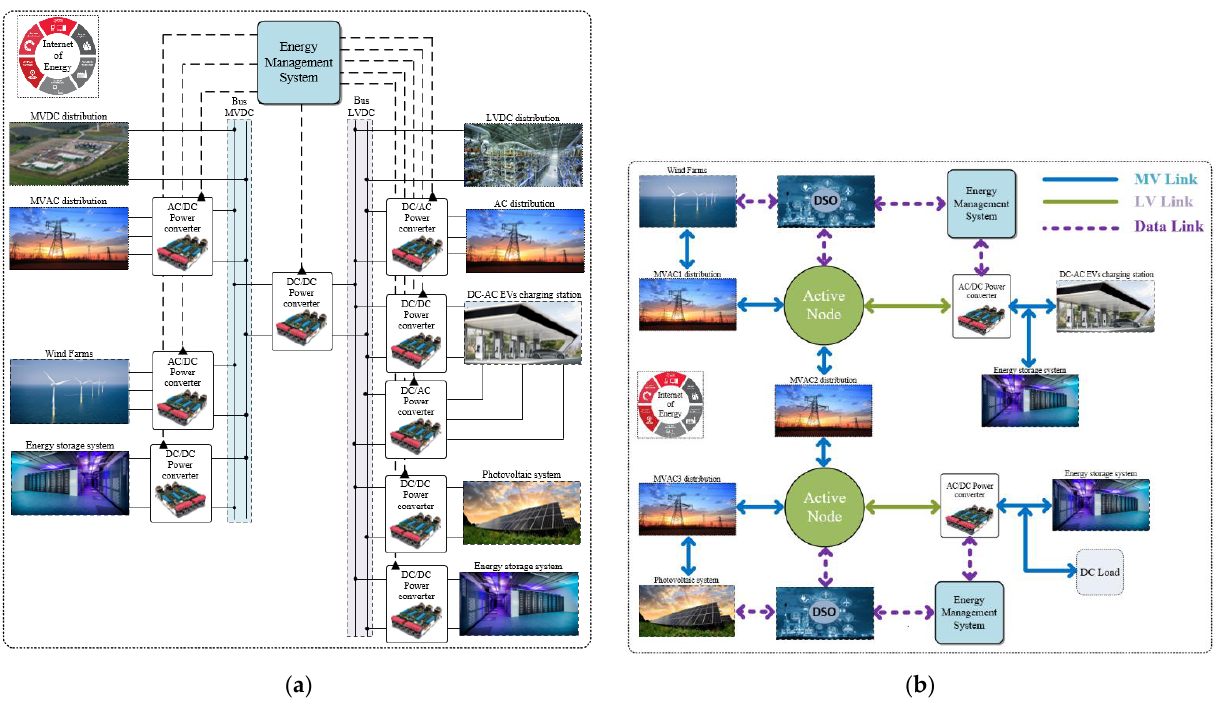
Figure 2. The energy router solid-state transformer in the Internet of Energy scenario: ( a ) DC distribution, ( b ) AC distribution.